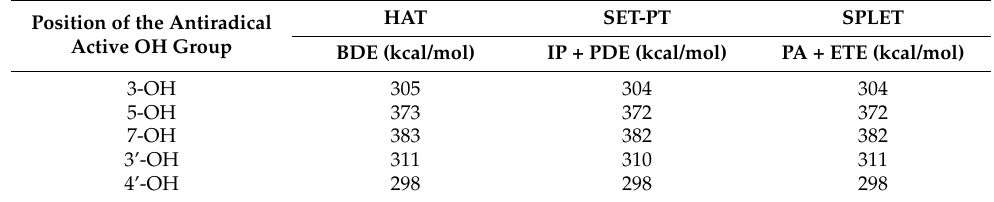
Table 3. Reaction mechanisms enthalpies of HAT, SET-PT, and SPLET for quercetin. Based on [108]. HAT SET-PT SPLET Position of the Antiradical Active OH Group BDE (kcal/mol)